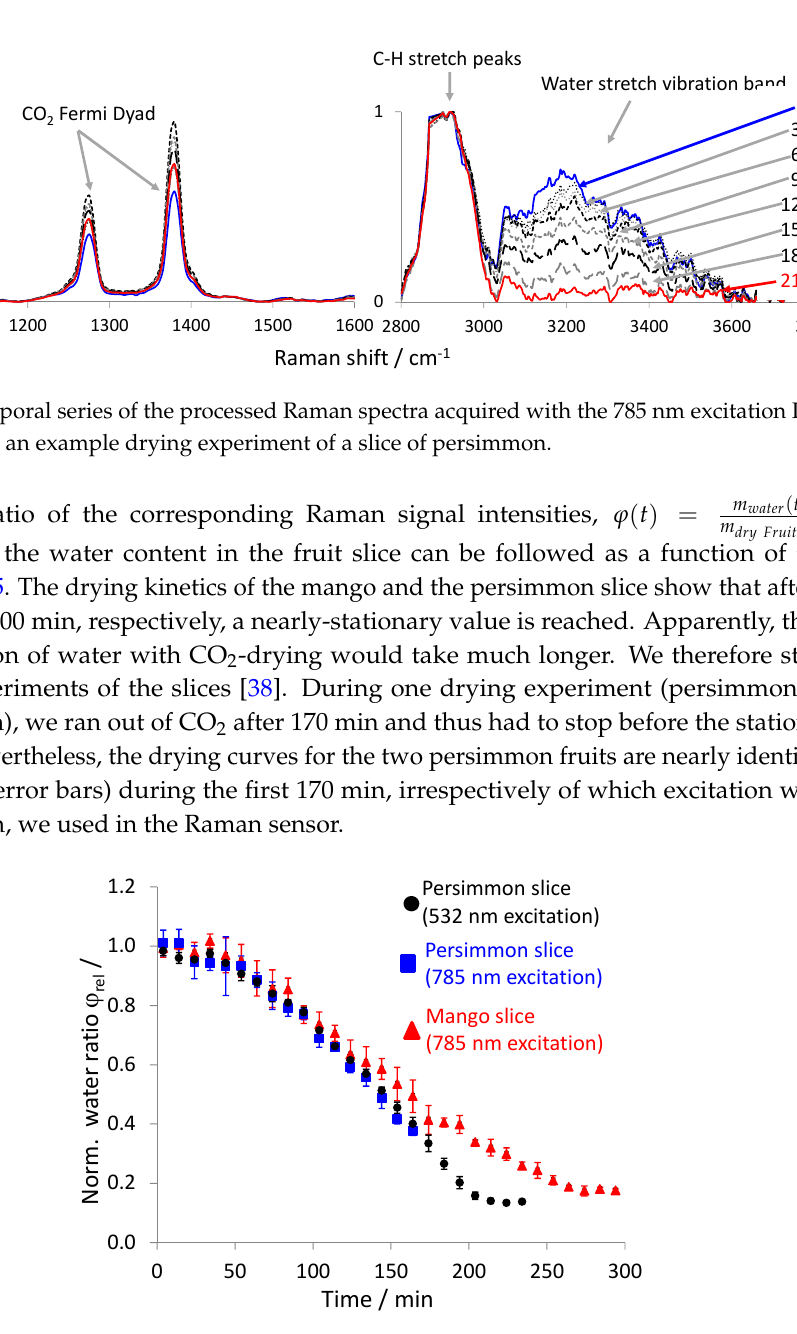
Figure 5. Drying kinetics of fruit slices measured with the Raman sensors. Mango slice of 2.73 g, persimmon slices of 2.09 g (785 nm excitation) and 3.48 g (532 nm excitation).